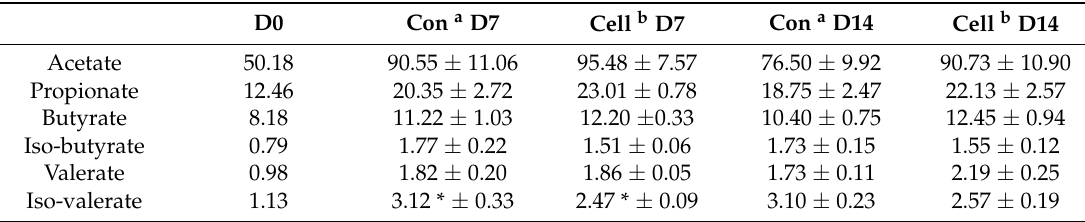
* Control—Cellulose pairs for the same time point that are statistically different (unpaired t -test, p < 0.05); a Control: average and standard deviation of duplicate cultures; b Cellulose supplementation: average and standard deviation of triplicate